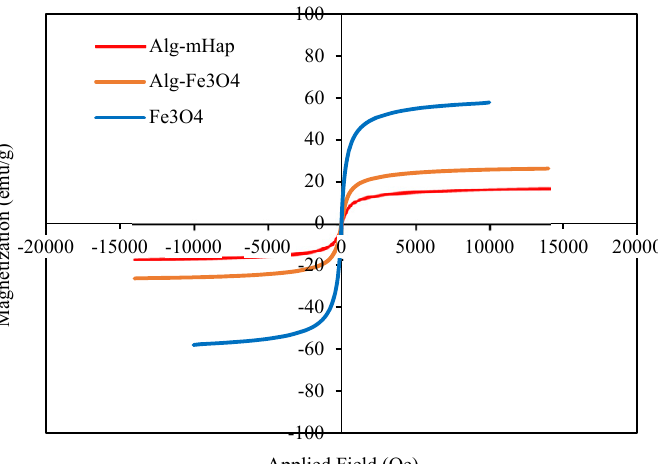
Fig. 4. Magnetic hysteresis loops of Fe